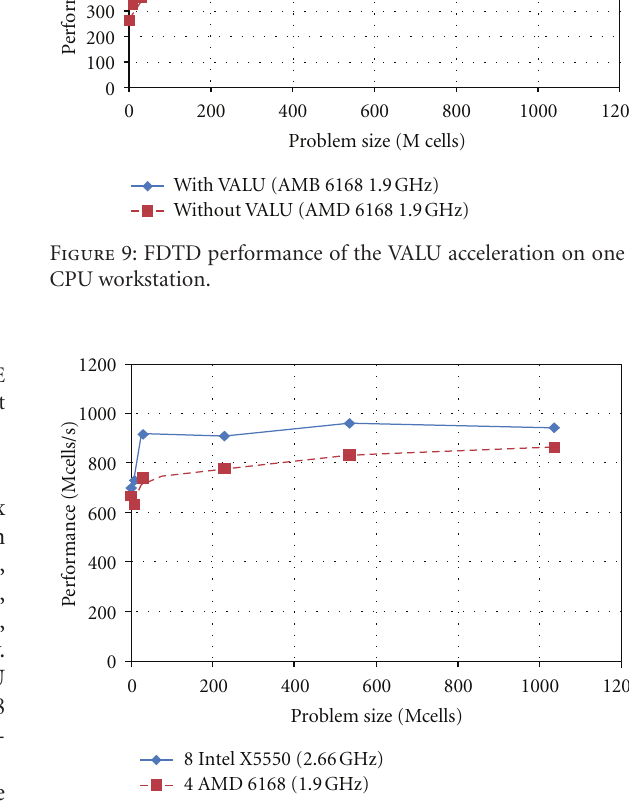
Figure 10: Performance comparison of parallel FDTD code on a workstation with 4 AMD CPUs and a cluster with 4 nodes (8 Intel